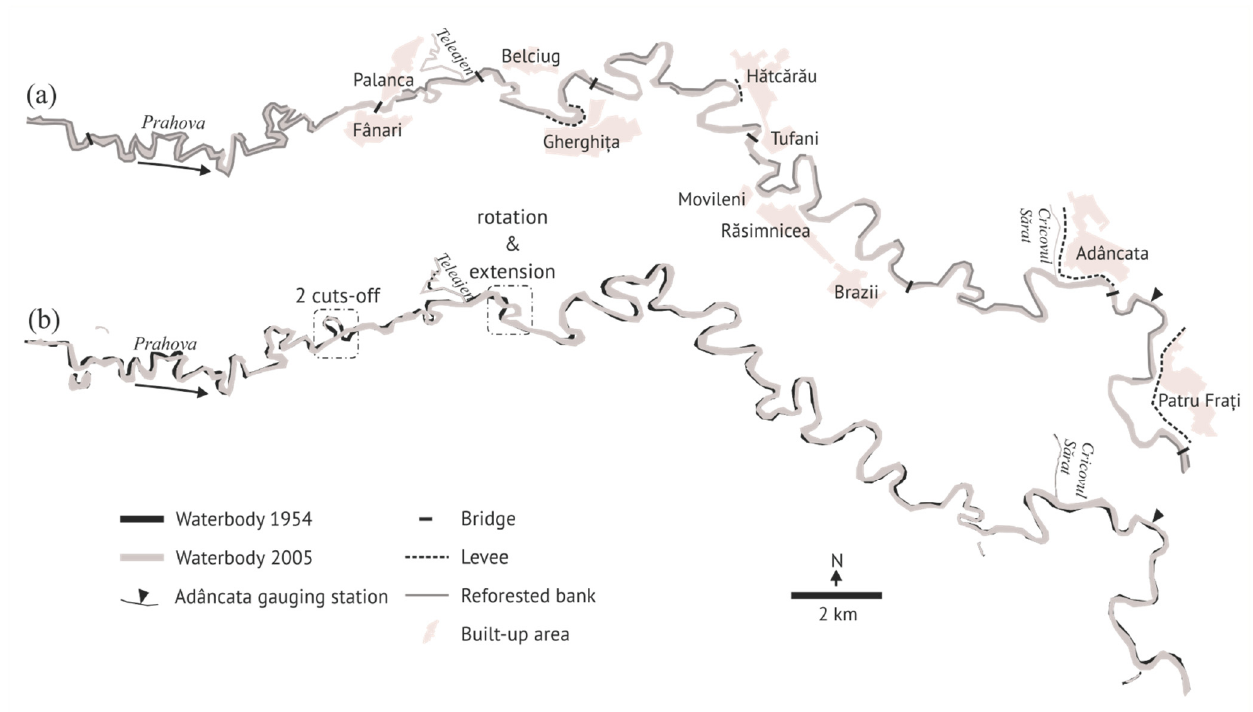
Figure 4. Particularities of the Lower Prahova River. ( a ) Local human pressures; ( b ) Lateral dynamics of river channel during the 1954–2005